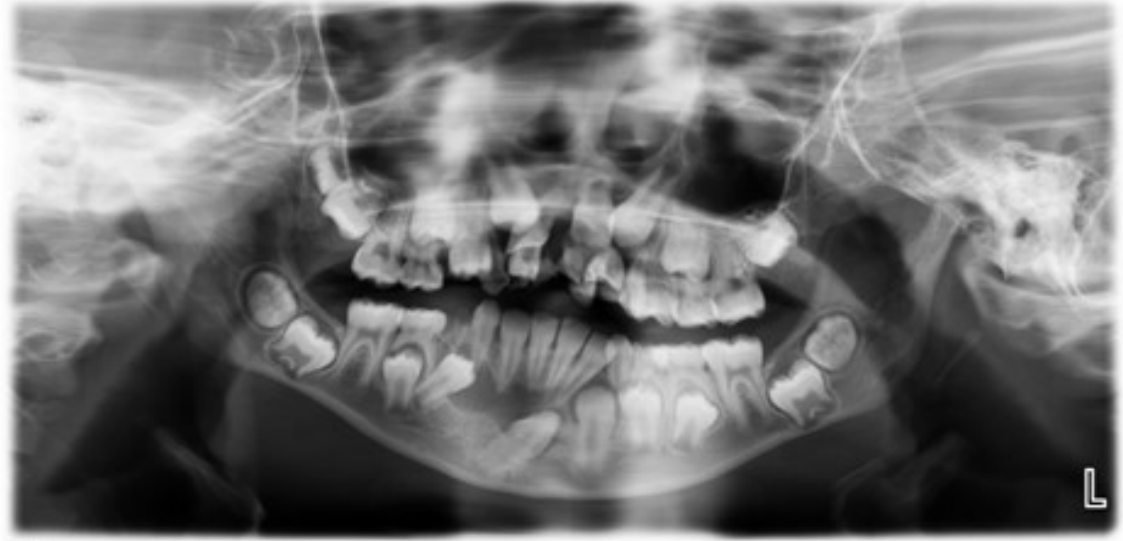
Figure 1. Panoramic Radiograph of an 11-year-old female with a dentigerous cyst.